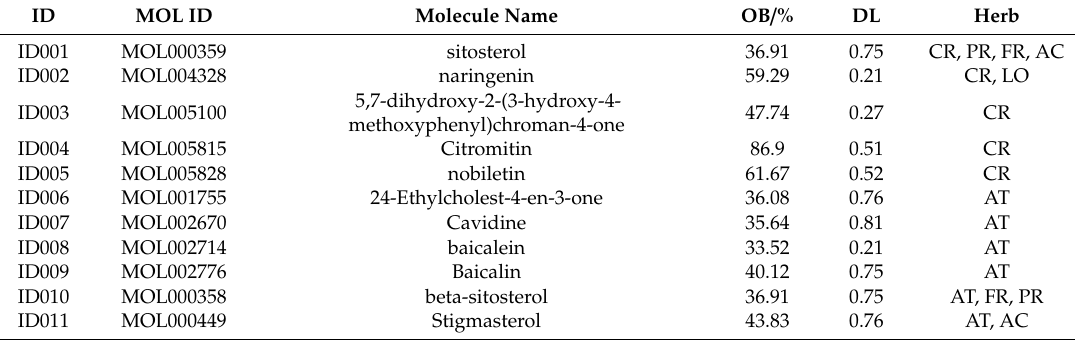
Table 1. Active ingredients and ADME parameters of Xia Qi Decoction